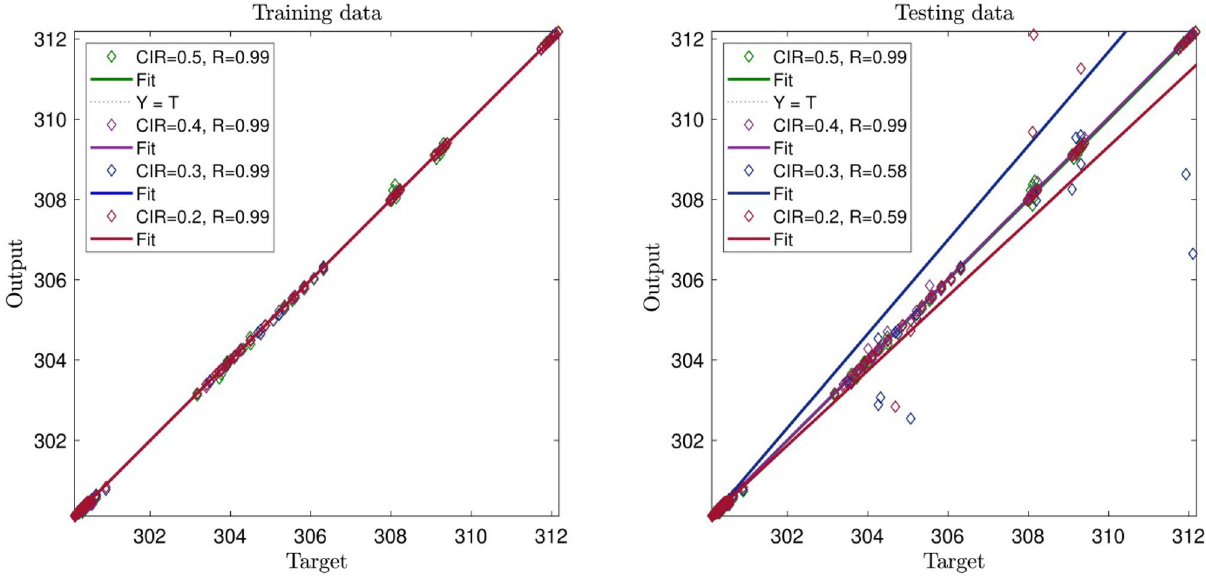
Figure 4. CIR (clustering parameter) changes in the ACOFIS learning processes when the pheromone effect is 0.2 and number of inputs is 4.